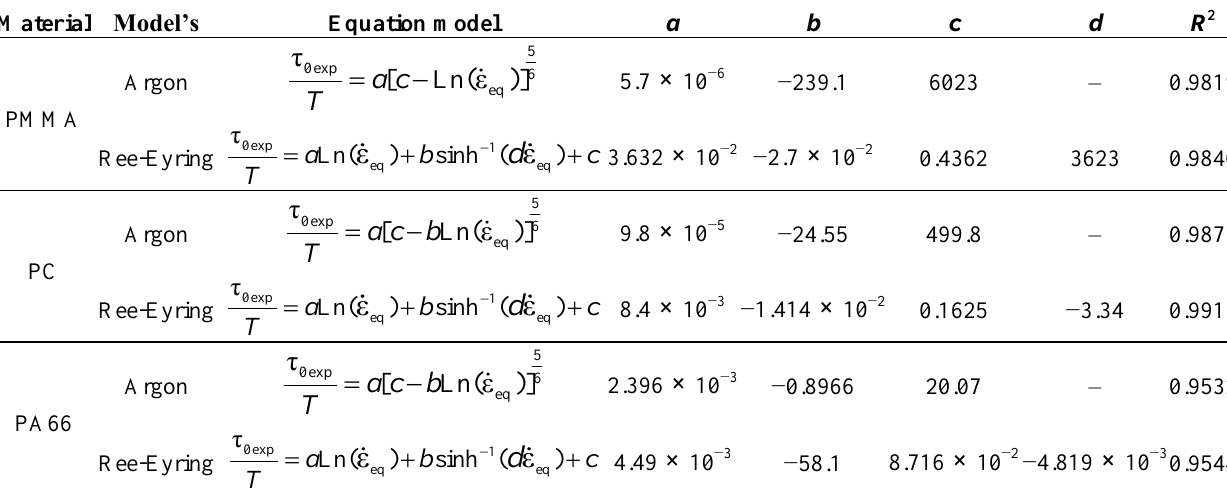
Table 4. Best-fit parameters for Argon’s and Ree-Eyring’s